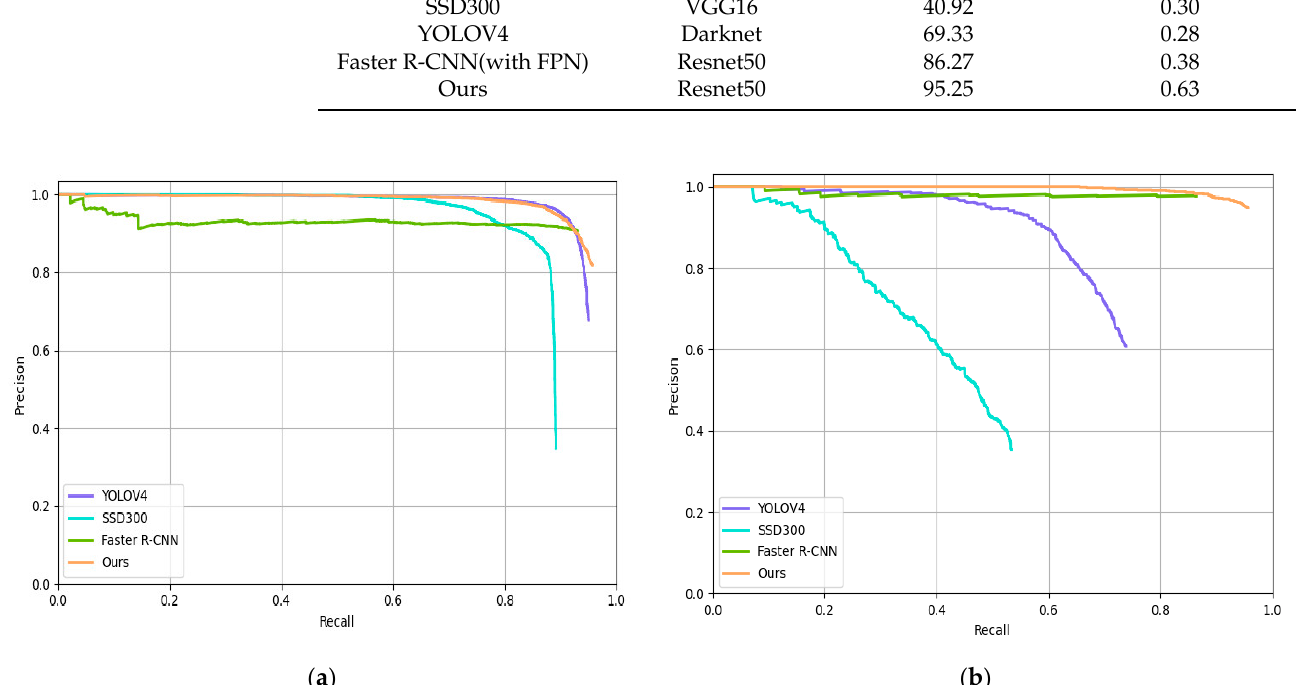
Figure 8. P ‐ R curve of different models on dataset. ( a ) Dataset II. ( b ) Dataset III. Figure 8. P-R curve of different models on dataset. ( a ) Dataset II. ( b ) Dataset